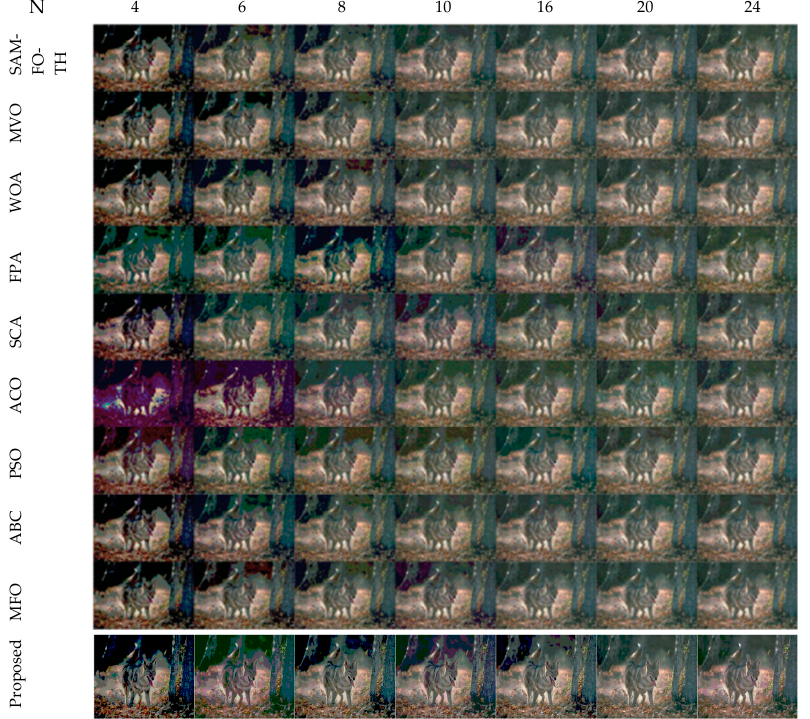
Figure 5. Segmented images of Image 1 at N = 4, 6, 8, 10, 16, 20, and 24, using SAMFO-TH, MVO, WOA, FPA, SCA, ACO, PSO, ABC, and MFO, and with the proposed model based on Kapur’s method. J. Imaging 2023 , 9 , x FOR PEER REVIEW